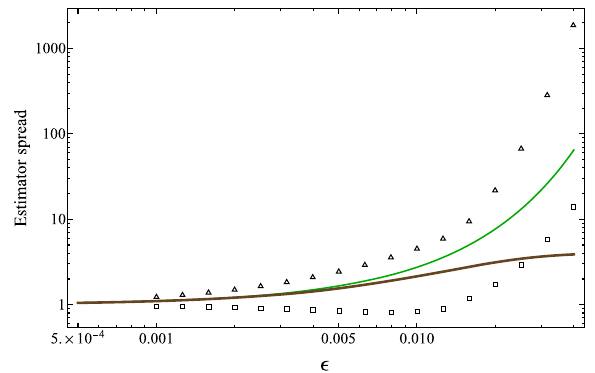
Fig. 5 The estimator spreads to mitigate local dephasing noise on a 50-qubit system. Solid green curve: Δ e max for probabilistic error cancellation and the lower bound for unbiased (1, 1)-mitigation protocols, which coincide as explained in the main text. Brown X i for 2-copy virtual distillation with GHZ curve: Δ e A with A ¼ 1 (cid:6) n i ¼ 1 2 state inputs and the lower bound for (2, 1)-mitigation protocols with the same bias, which coincide as explained in Supplementary Note X i for 11th order 2. Triangles and rectangles: Δ e A with A ¼ 1 (cid:6) n i ¼ 1 2 noise extrapolation with GHZ state inputs (triangles) and a lower bound for (1, 12)-mitigation protocols with the same bias